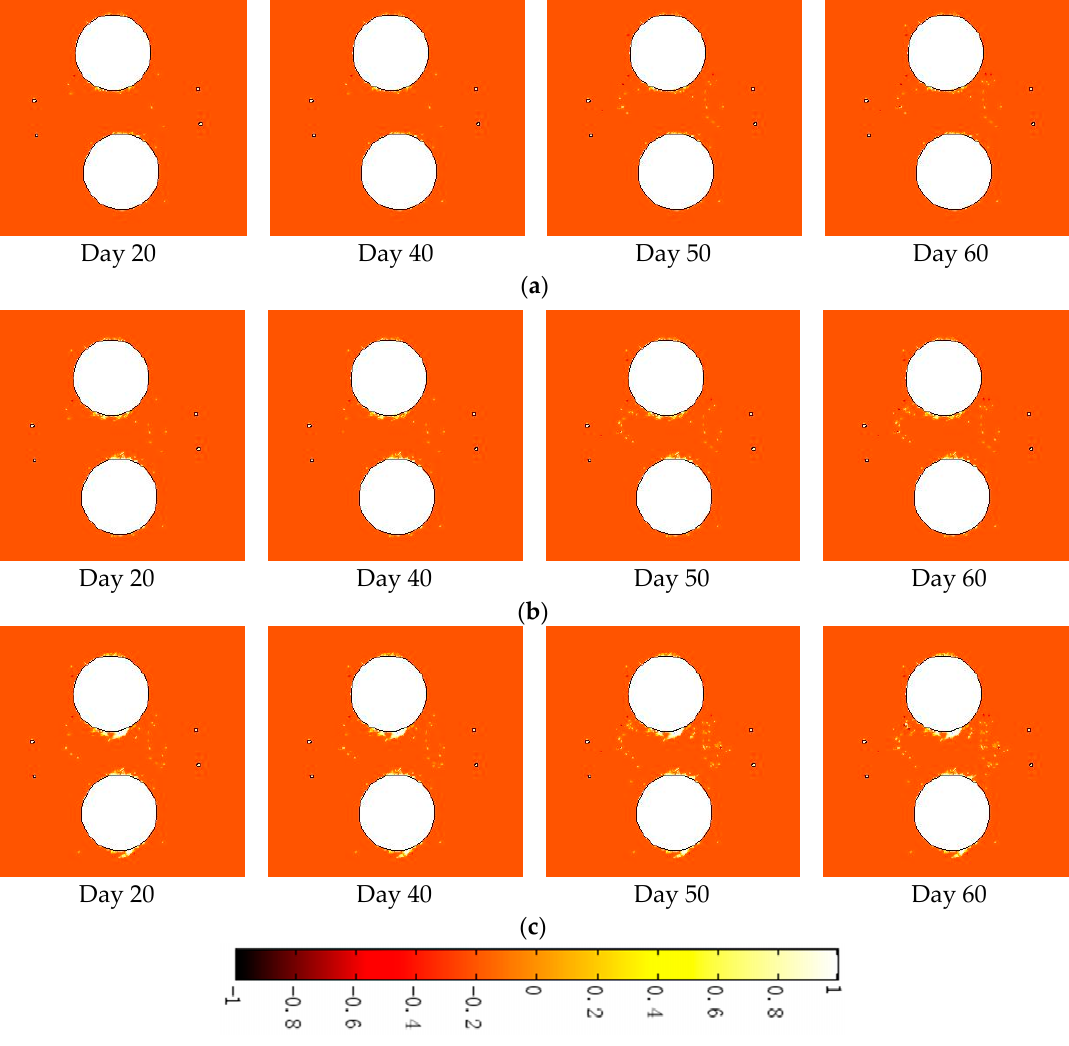
Figure 11. Damage zone evolution under different in situ stress conditions at the heating stage: ( a )